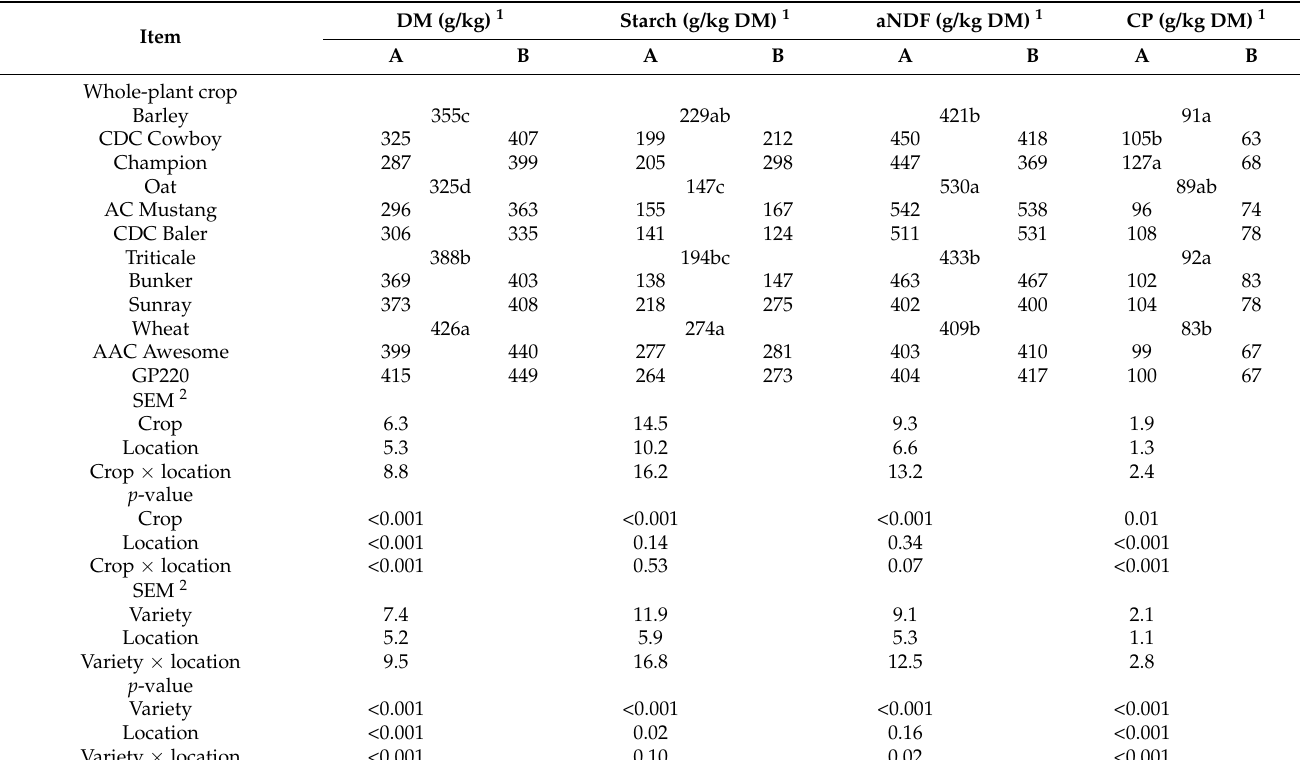
Table 1. Whole-plant dry matter (DM), starch, neutral detergent fiber (aNDF), and crude protein (CP) concentrations of whole-plant cereal crops grown and harvested at two locations (A, B) in central Alberta. Item